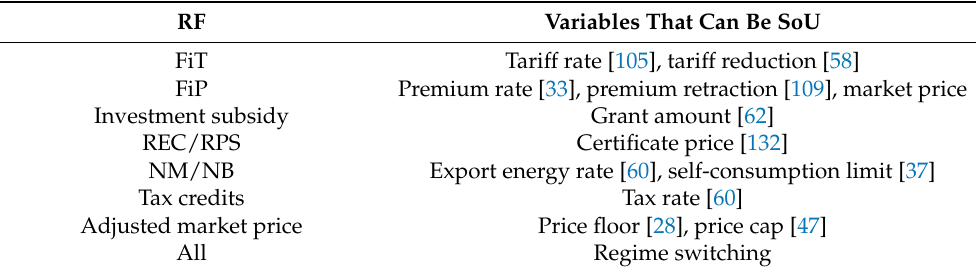
Table 2. Variables that can be an SoU depending on the RF.